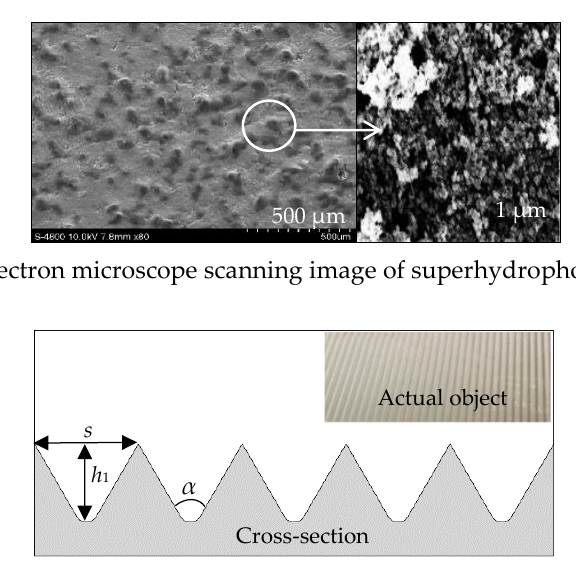
( b ) Cross-section of micro-riblet surfaces.